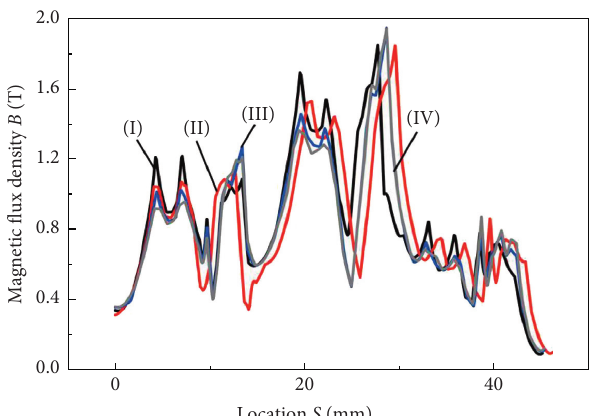
Figure 6: Magnetic field distribution in magnetic fluid sealing clearance under different radial clearances (I), 0.4mm; (II), 0.5mm; (III), 0.6mm; and (IV), 0.7 mm.